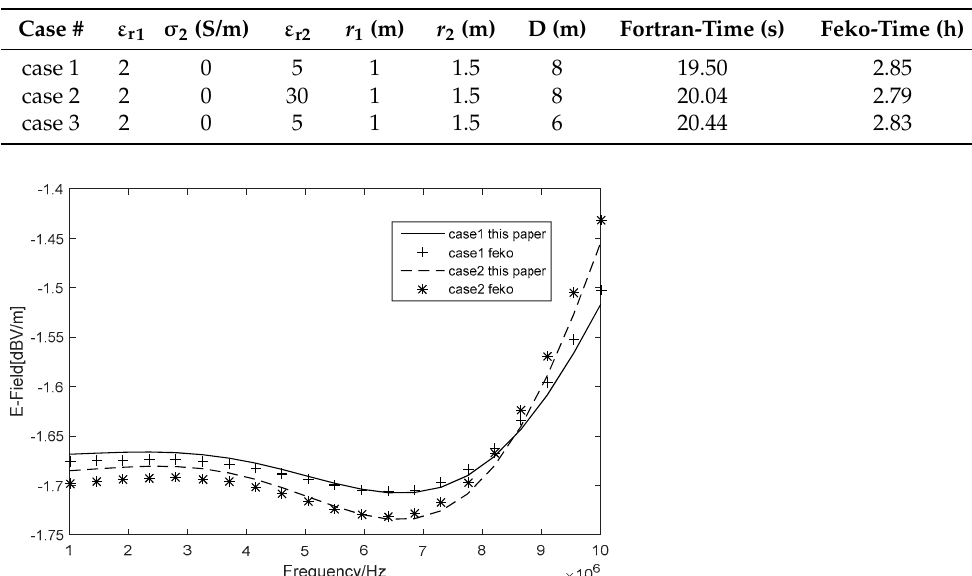
Table 1. Different simulation cases for buried medium-coated conducting sphere.